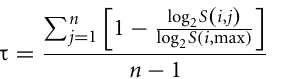
Table S1 | KSTest p -values for CNS Gene Subsets . Table S2 |Wilcoxon Ranked Sum p -values for CNS Gene Subsets . Table S3 | KSTest p -values for CNS’ Gene Subsets . Table S4 |Wilcoxon Ranked Sum p -values for CNS’ Gene Subsets . Table S5 | Enriched FunctionAnnotation inAlpha Duplicate Gene Lists based on CNSAnnotation (Bonferroni p -value ≤ 0.001) . Table S6 |Arabidopsis Gene mRNA Half-Life and CNS Status . Table S7 | GEO Datasets Used inThis Study